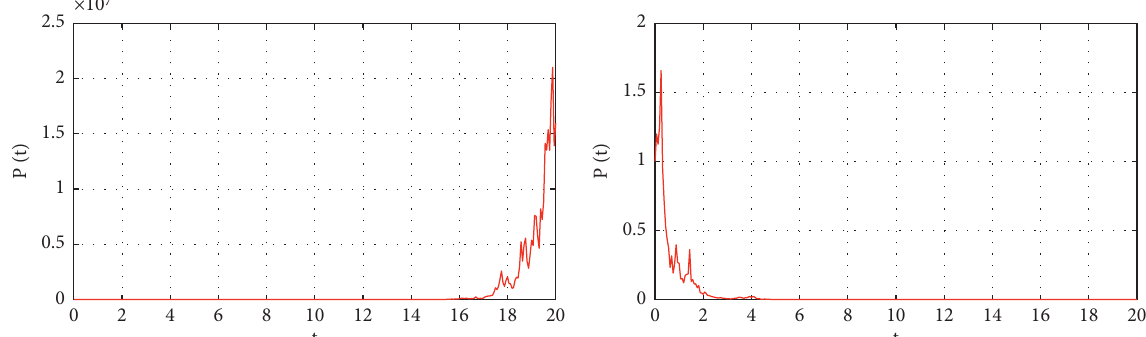
0.5 0 Figure 3: The trajectories of system (91) with P � 1 ,H � 0 . 5. (a) θ � 2 , u � 1 ,v � 1. (b) θ � − 1 , u � 1 ,v � 1. The trajectories of system (91) 0 are almost surely exponentially unstable for (a) but stable for (b) in the sense of Theorem 5